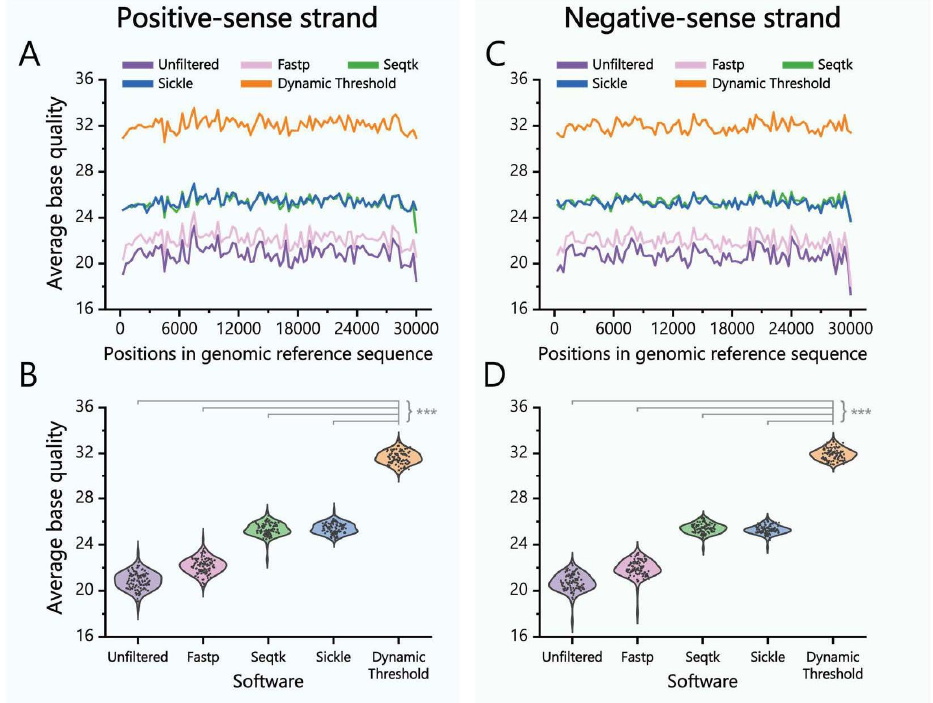
Figure 4. Comparing the low-quality data filtering results of five approaches by average base quality within each window length (300 bases). ( A ) The specific average base quality of SARS-CoV-2 positive-sense reference strand at each site. ( B ) The overall average base quality distribution of SARS-CoV-2 positive-sense reference strand at each site. ( C ) The specific average base quality of SARS-CoV-2 negative-sense reference strand at each site. ( D ) The overall average base quality distribution of SARS-CoV-2 negative-sense reference strand at each site. *** p ≤ 0.001. The test of significance [4,31,32,33,34,35,36,37,38] between the nucleobase filtering